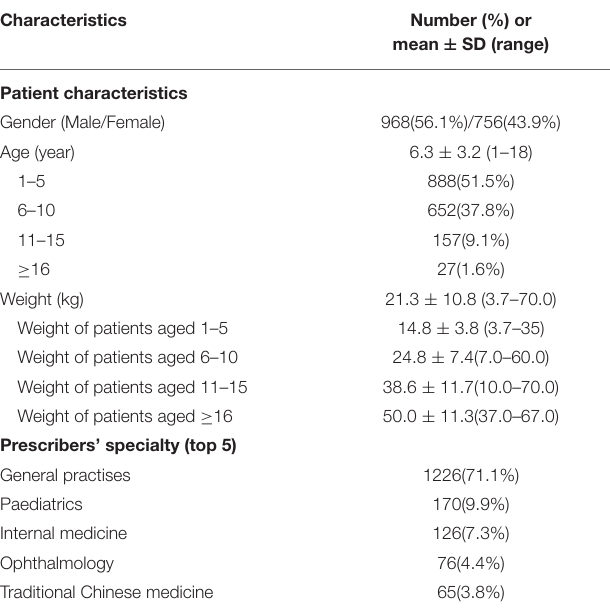
TABLE 2 | Characteristics of paediatric outpatients in this